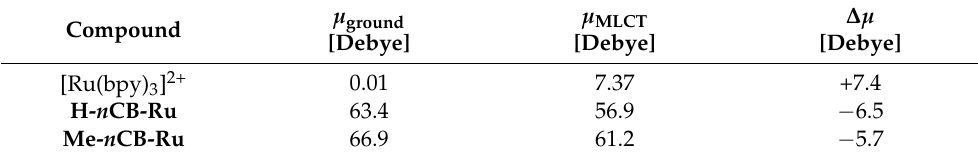
Table 6. Calculated dipole moments at the optimized